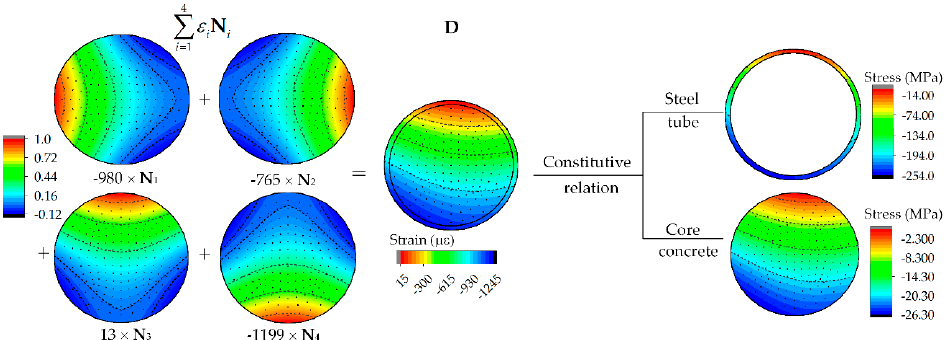
Figure 5. The strain / stress fields of section 11 in arch-A under 130 kN.